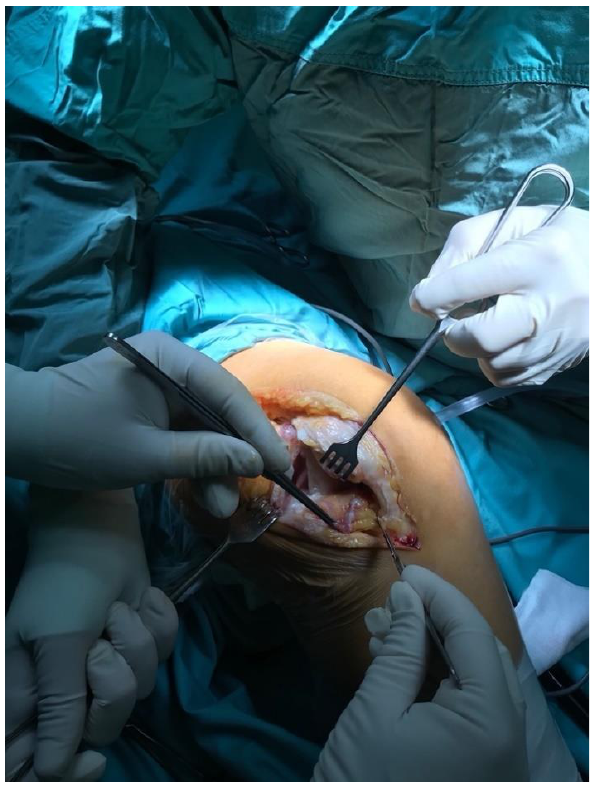
Figure 3. Lateral arthrotomy with the Hoffa fat pad preparation.